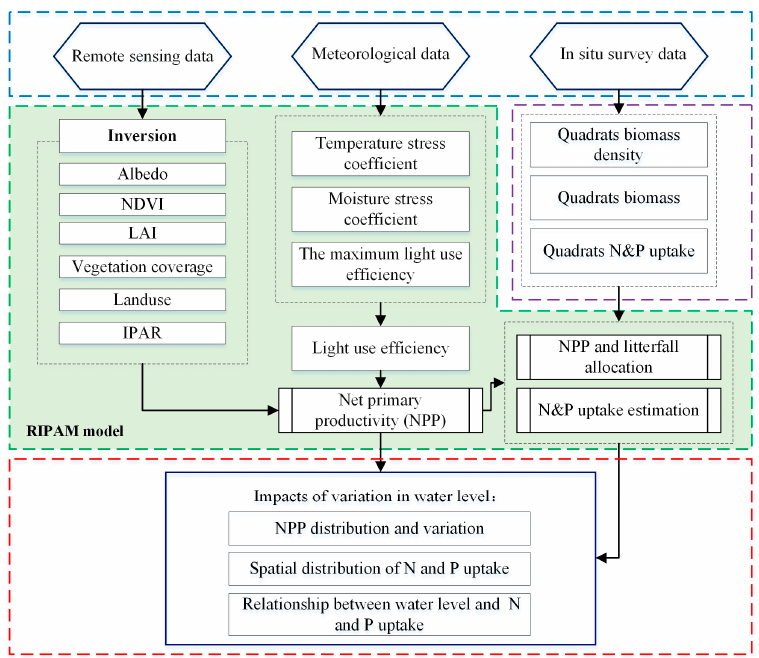
Figure 2. Framework of the N and P uptake simulation. IPAR: the amount of photosynthetically active radiation intercepted by plants; LAI: leaf area index; NPP: net primary productivity; NDVI: normalized difference vegetation index.